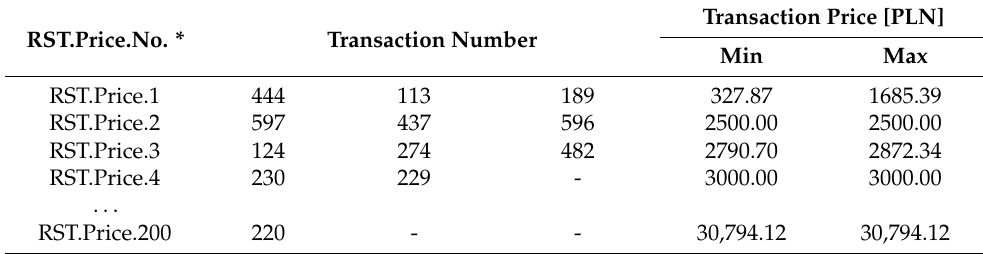
Table 4. Example of RST.Price. groupings of homogeneous prices of property transactions within a selected homogeneous area. Source: own elaboration.